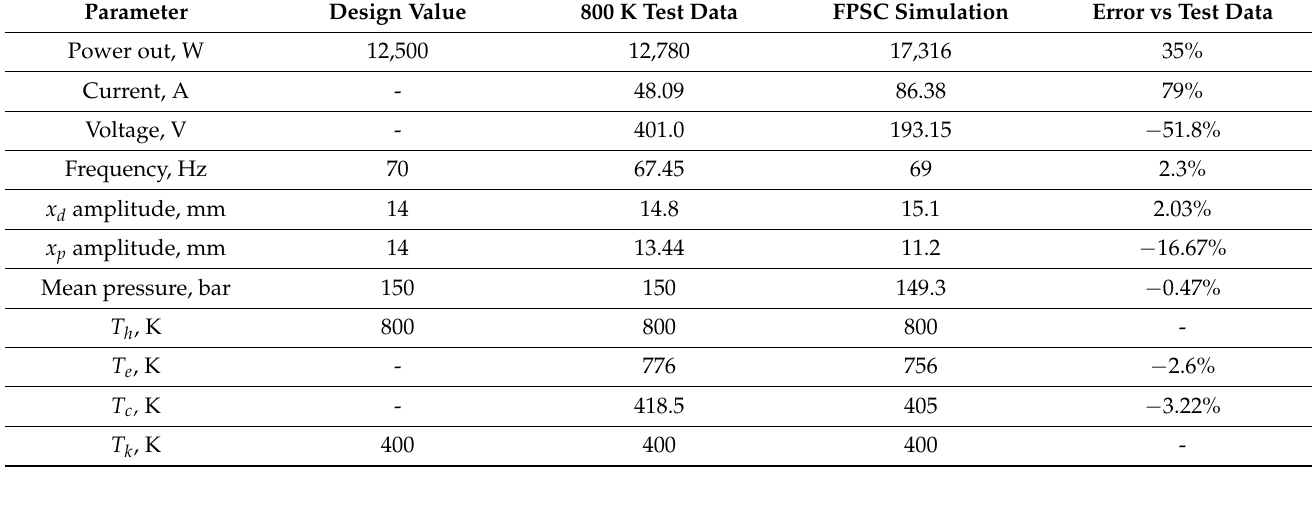
Table 4. CTPC model simulation results versus test data.